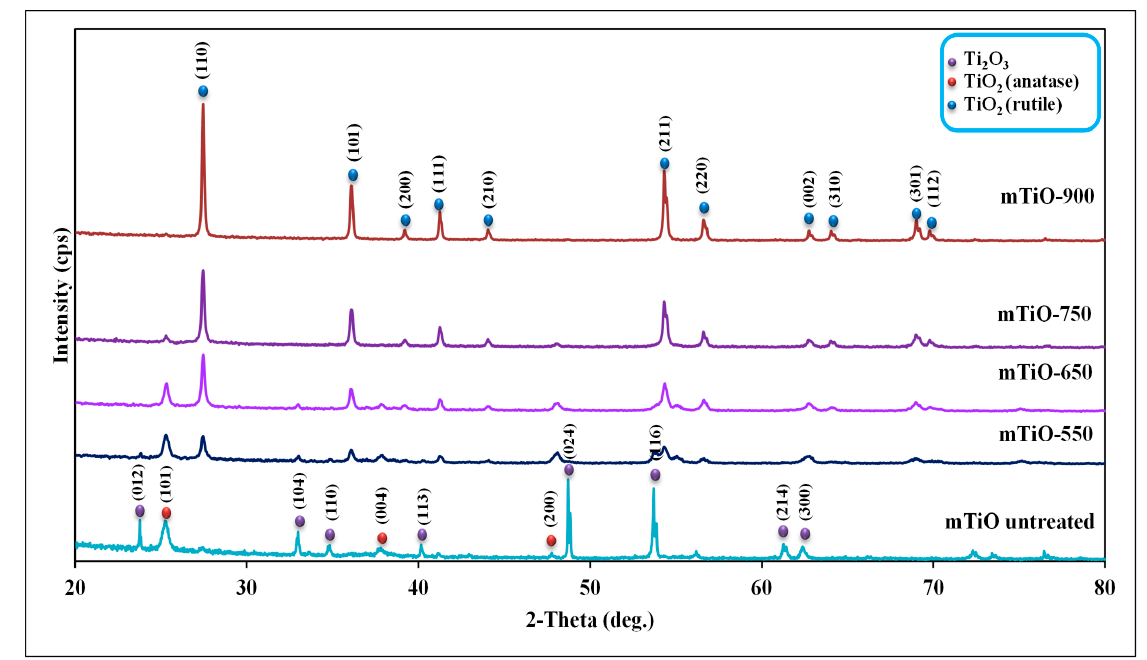
Figure 2. XRD patterns of treated Ti 2 O 3 catalysts.